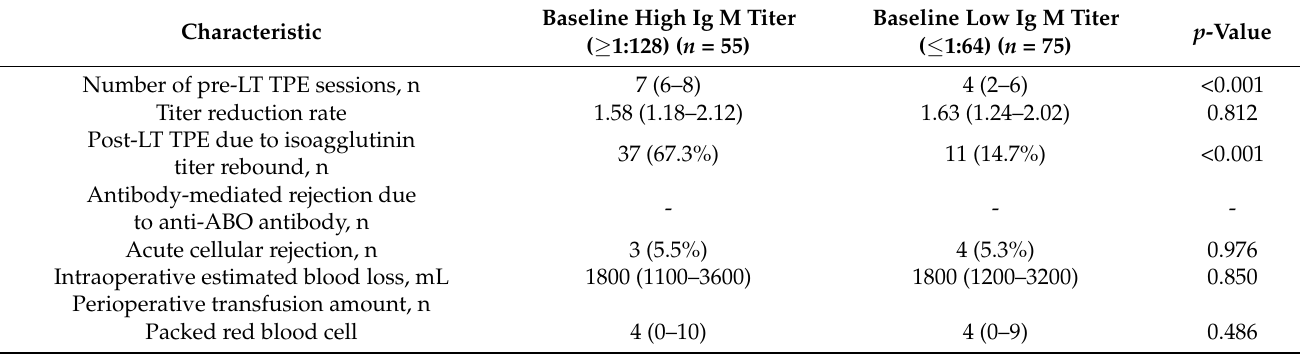
Table 3. Comparison of plasma exchange-related parameters and post-transplant outcomes between patients with initial baseline high and low Ig M isoagglutinin